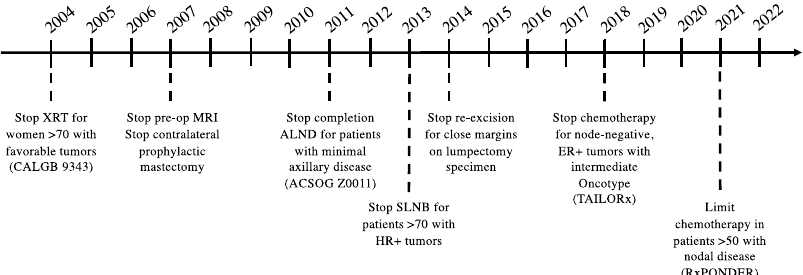
Fig. 1 Timeline of national recommendations for breast cancer surgery de-escalation. ALND, axillary lymph node dissection; ER + , estrogen receptor positive; HR + , hormone receptor positive; MRI, magnetic resonance imaging; SLNB, sentinel lymph node biopsy; XRT,